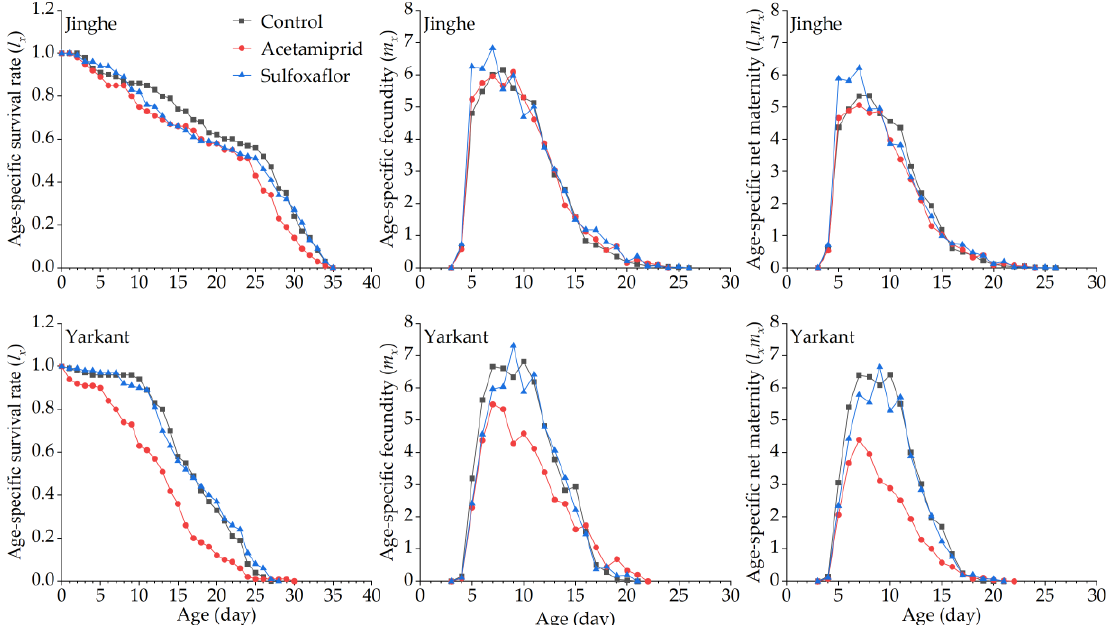
Figure 6. Effects of sublethal concentrations (LC 25 ) of acetamiprid and sulfoxaflor on the age-specific survival rate ( l x ), age-specific fecundity ( m x ), and age-specific maternity ( l x m x ) of A. gossypii of the F 2 generation in Yarkant and